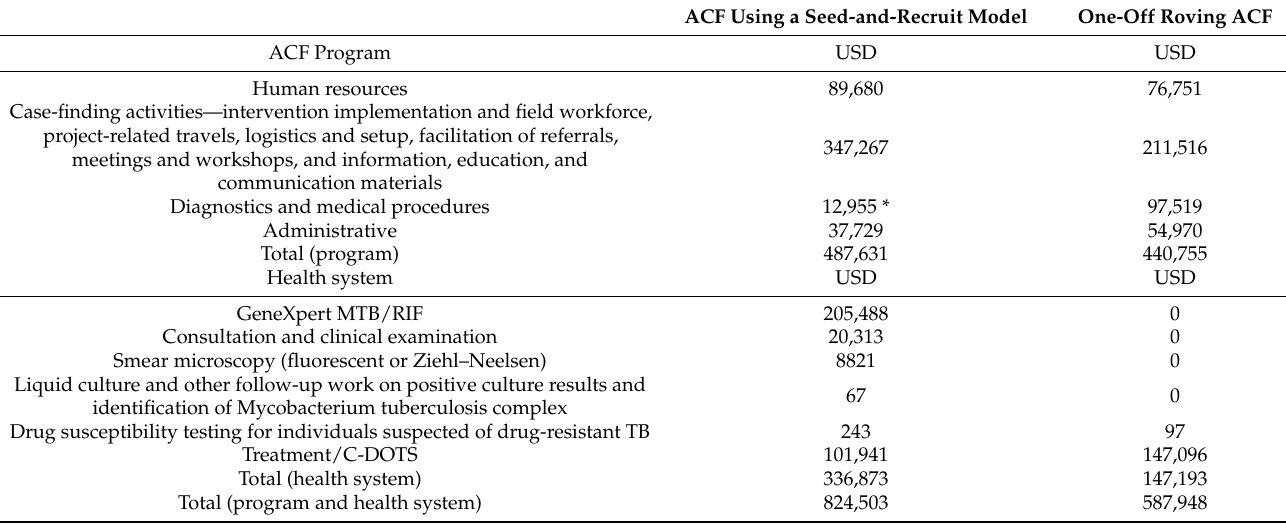
Table 3. Program and health system costs elements of TB active case-finding